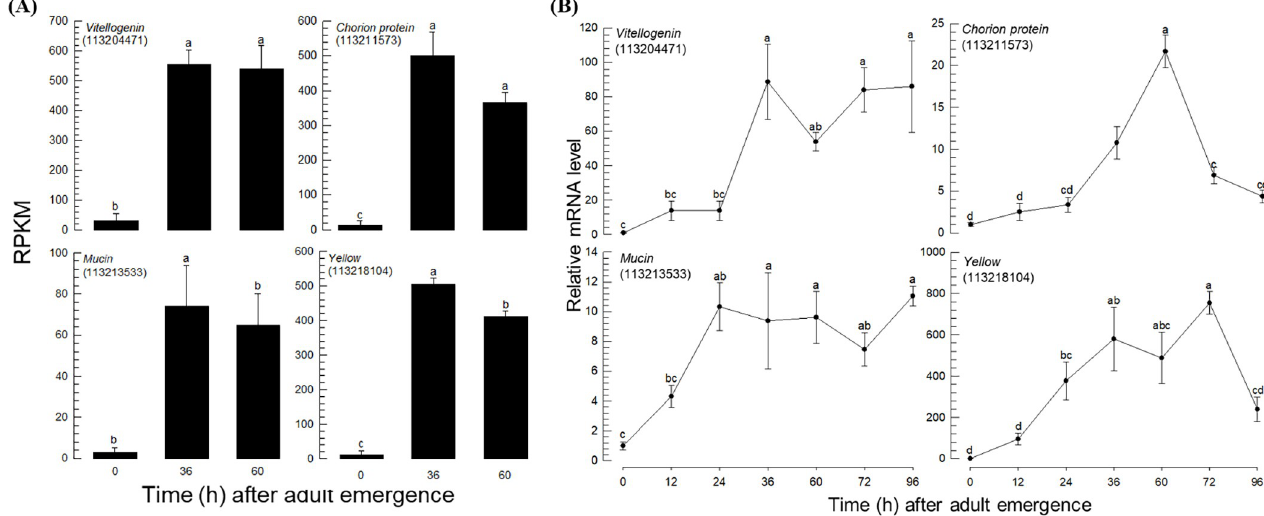
Fig 4. Expression analysis of the selected egg proteins during F . occidentalis ovarian development. The NCBI Gene ID is in each parenthesis. (A) RNASeq analysis. (B) RT-qPCR analysis. Each measurement was replicated 3 times. The figures in parentheses indicate LOCs, which are the NCBI gene IDs. Different letters above the standard deviation bars represent significant differences among the means at type I error = 0.05 (DMRT test)].